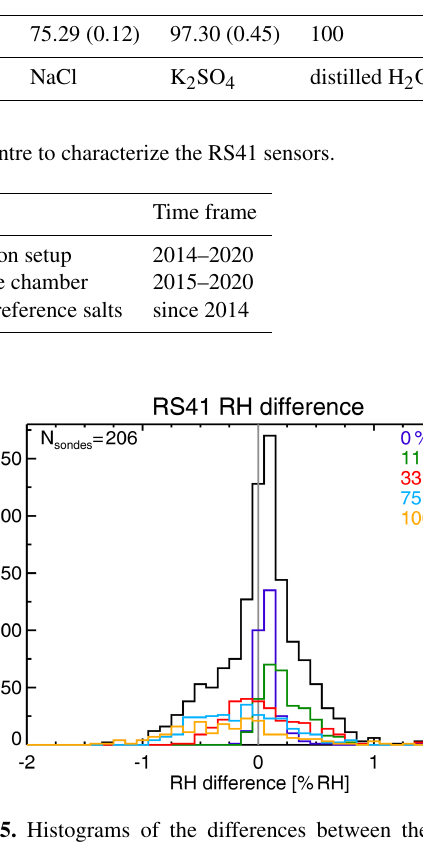
Table 3. Humidity values achieved in the SHC using desiccant, pure water, and four different saturated salt solutions at 25 ◦ C. The uncer- tainties of the RH values are given in parentheses. Data taken from Greenspan (1977). All radiosondes were tested twice at each RH level, except at 100%RH.